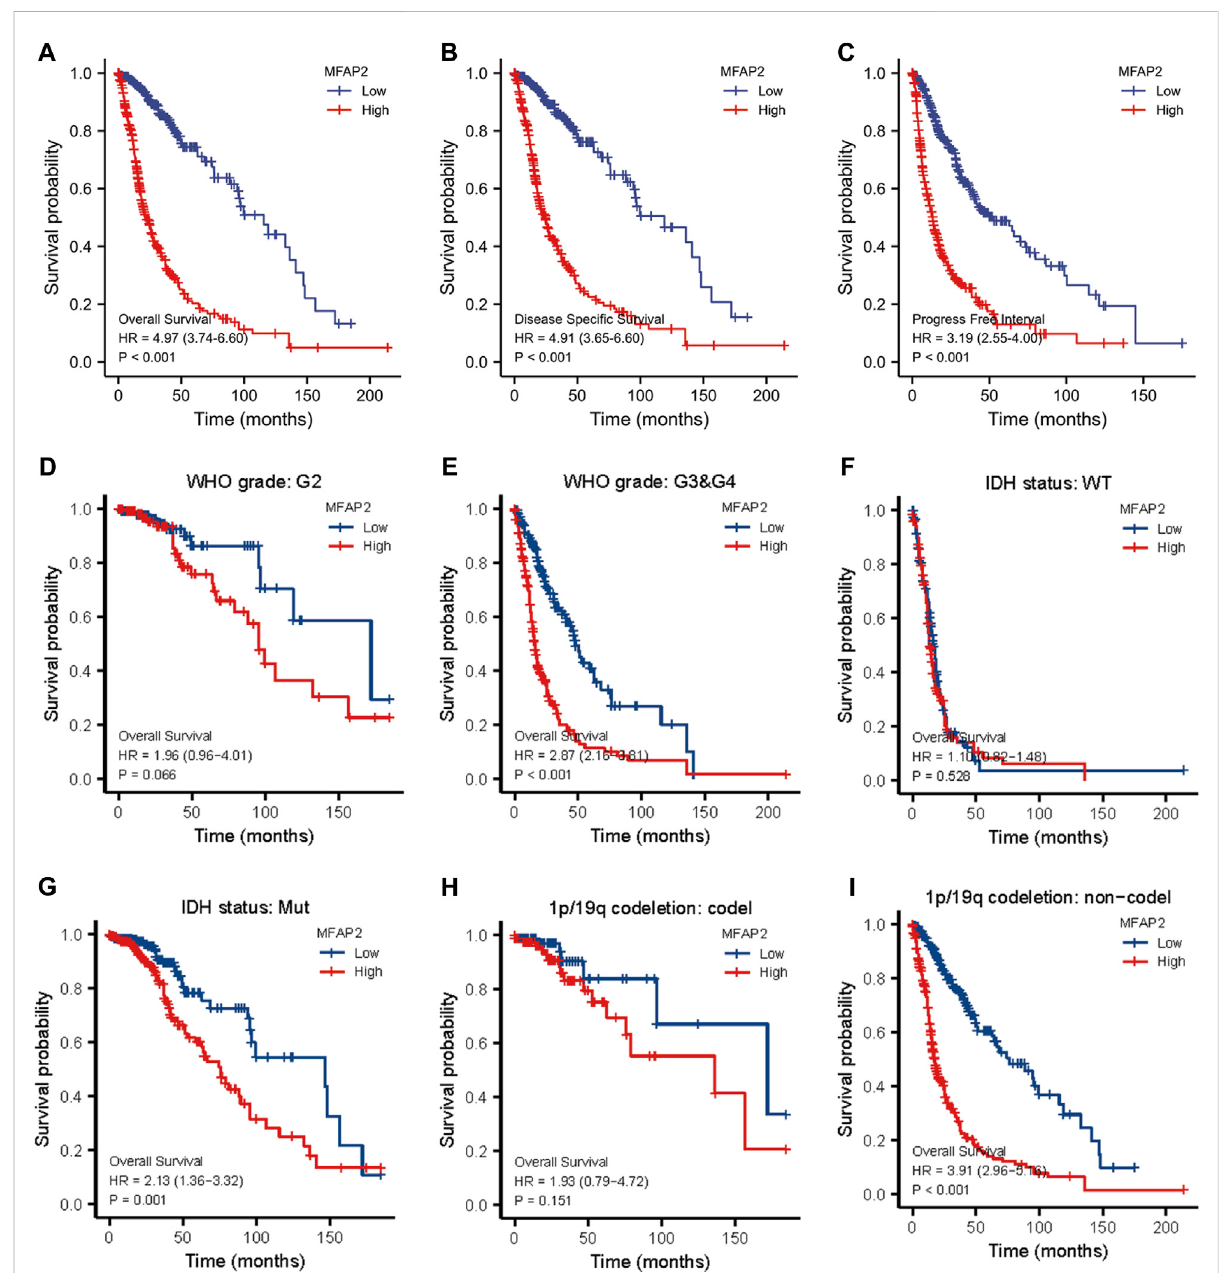
FIGURE 7 Kaplan – Meier survival analysis of patients with glioma based on MFAP2 expression in the TCGA database. (A) Overall survival. (B) Disease- speci fi c survival. (C) Progression-free survival. (D) Overall survival of patients with WHO G2 glioma. (E) Overall survival of patients with WHO G3/ G4 glioma. (F) Overall survival of patients with IDH wild-type glioma. (G) Overall survival of patients with IDH mutated glioma. (H) Overall survival of patients with 1p/19q codeletion glioma. (I) Overall survival of patients with non-codeletion